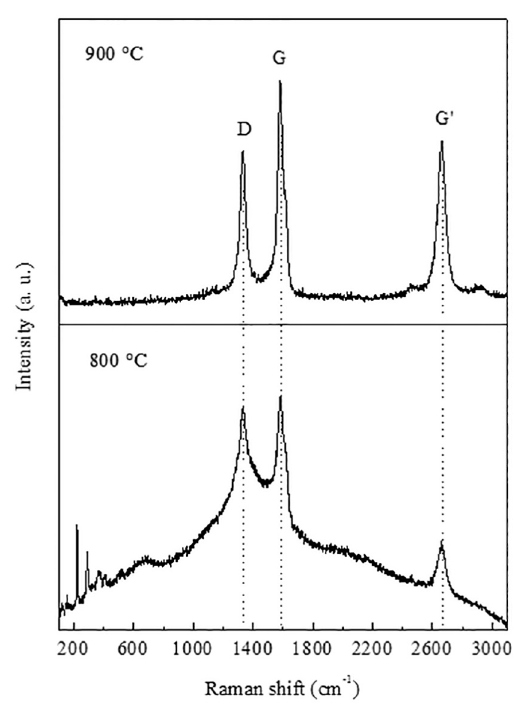
Figure 2: Raman spectra of CNTs growth on Zirconia wafers substrates at two different temperatures.